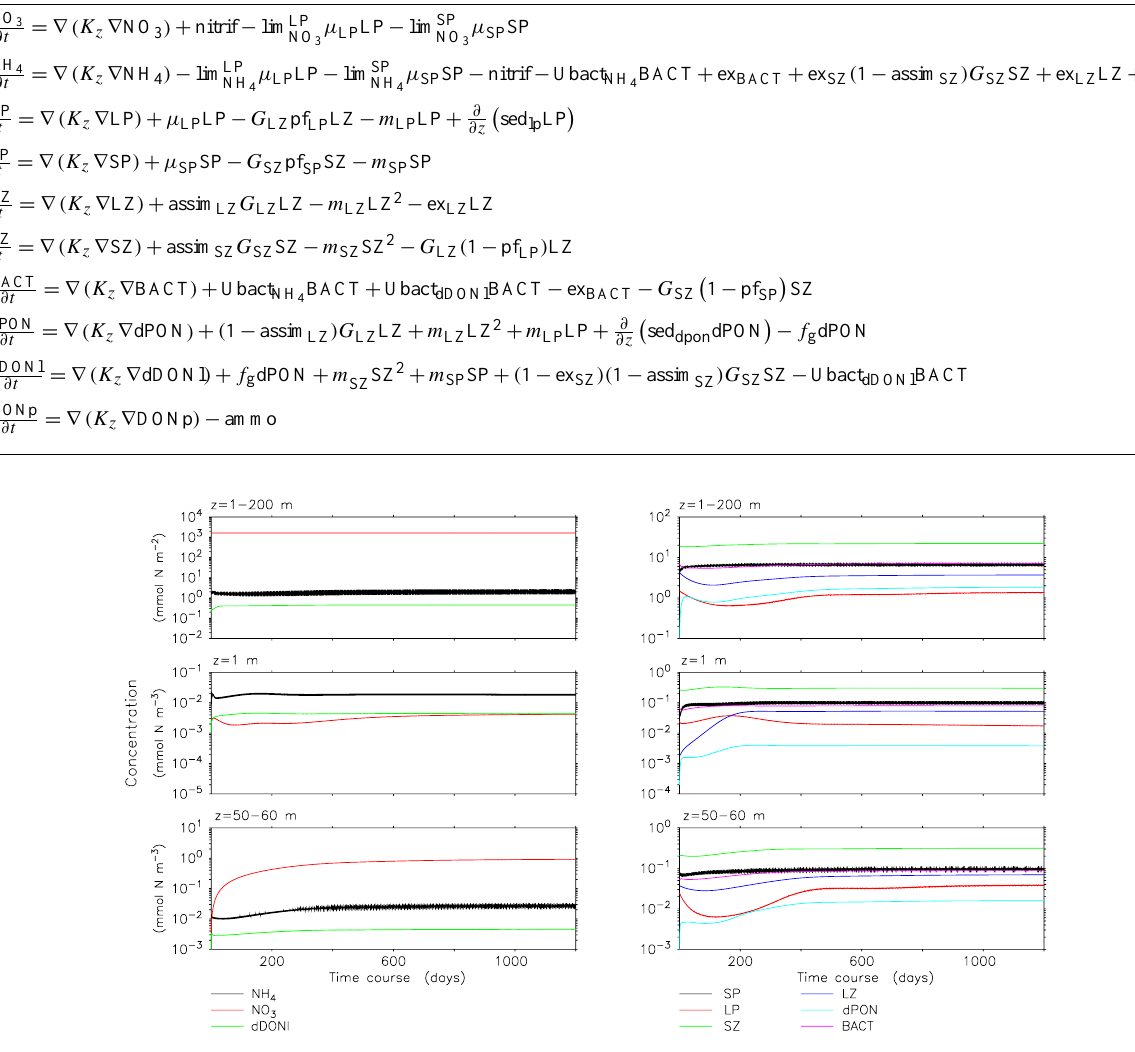
Fig. 4. Time course of the model state variables in the dissolved (left panels) and particulate (right panels) form integrated over the numerical domain (upper panels), at the surface (middle panels) and within the subsurface maximum of primary production (lower